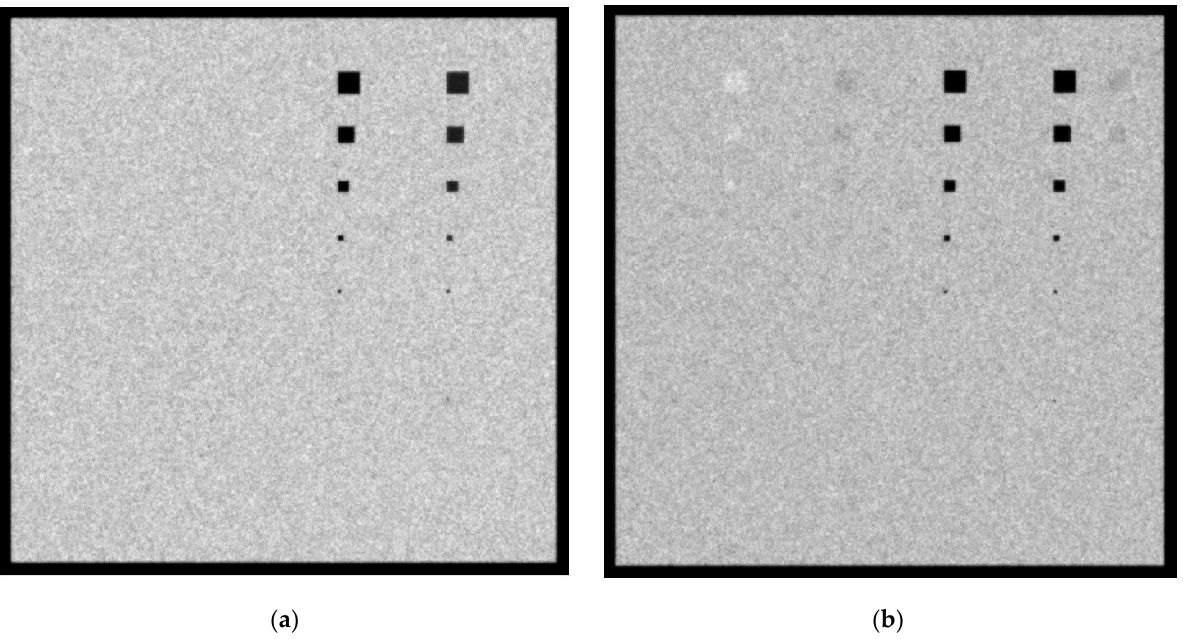
Figure 5. A 4.2 cm phantom image for Mo/Mo 5 mGy and 28 kVp spectrum with ( a ) 0.1 cm lesion thickness and ( b ) 0.5 cm lesion thickness.